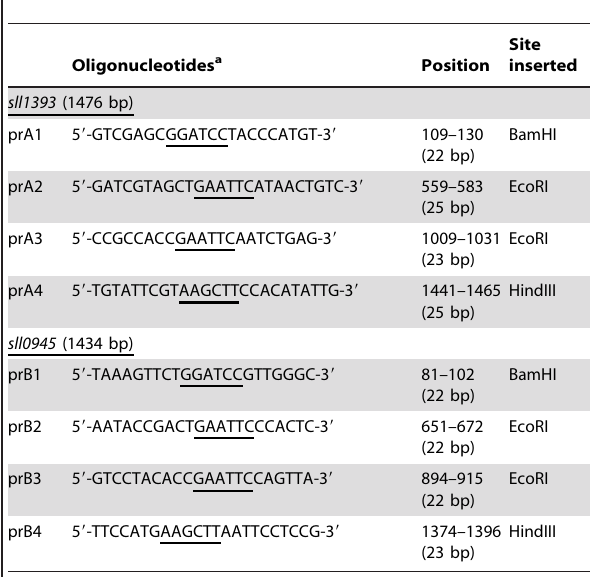
Table 1. Oligonucleotide sequences used to construct 3 pSHK1393 and pSHK0945